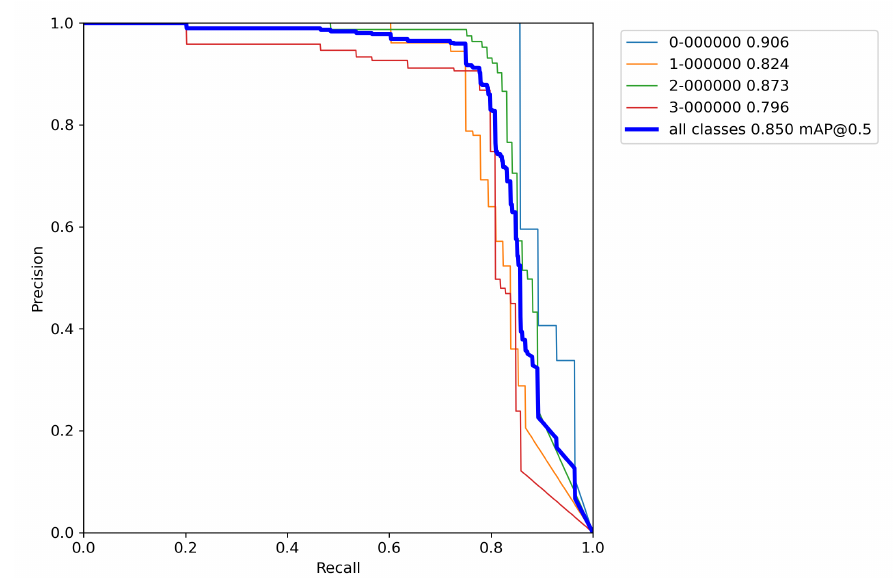
Figure A11. Model trained with augmentation pipeline P–R curve—Experiment